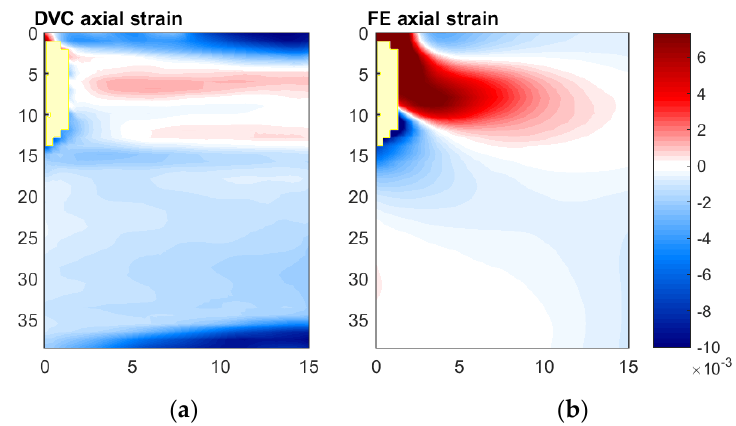
Figure 12. Comparison of axial strain fields measured and predicted, Digital Volume Correlation ( a ) and Finite Element ( b ), for Displacement Step 3 relative to reference scan. Measurements with correlation coefficients below 0.9 have been excluded from both fields, their spatial locations are shown in yellow.